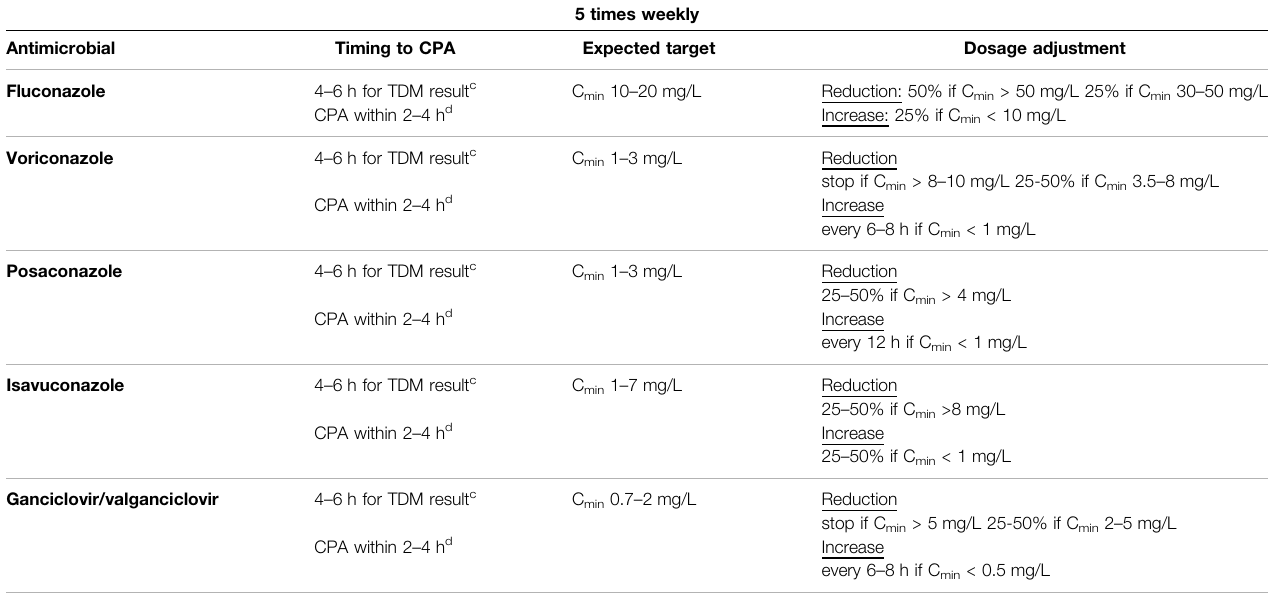
Table 1 . Optimal pharmacodynamic targets both for maximizing clinical ef fi cacy and for minimizing resistance occurrence were considered a plasma steady-state concentration above